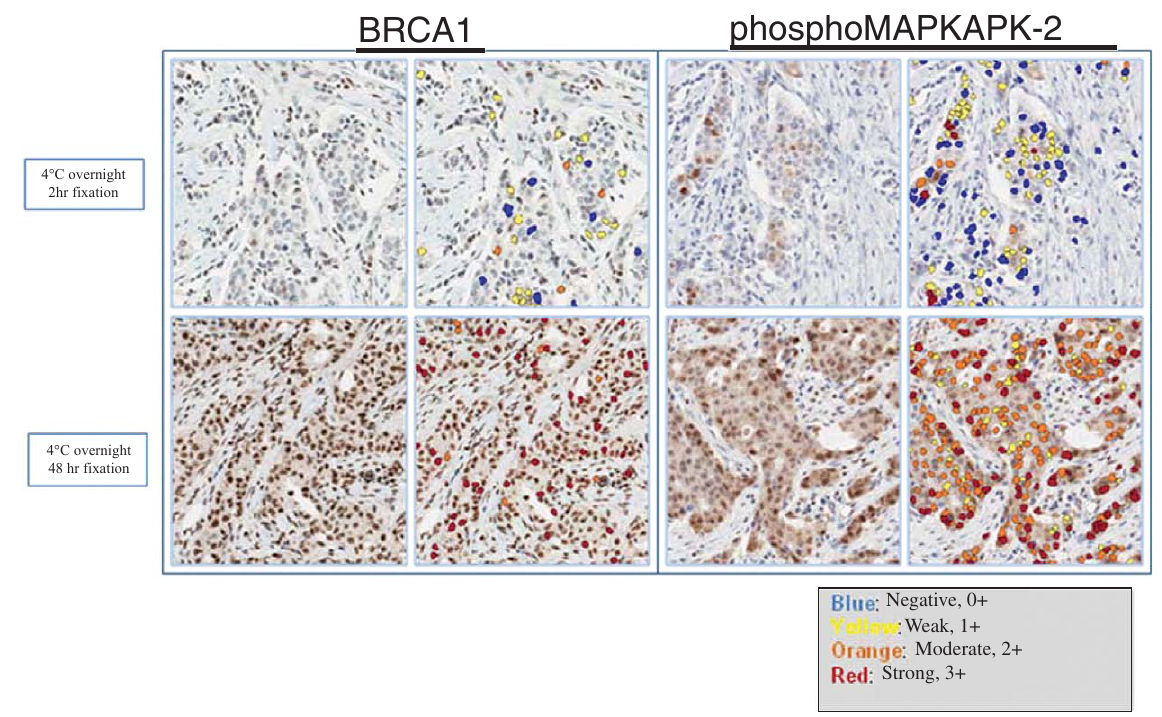
Fig. 4. IHC staining for BRCA1 and pMK2 from separately fixed samples of an FFPE-derived breast cancer patient specimen. (for each depicted biomarker, left panel=IHC staining, right panel=IHC staining with Aperio-based macro scoring).